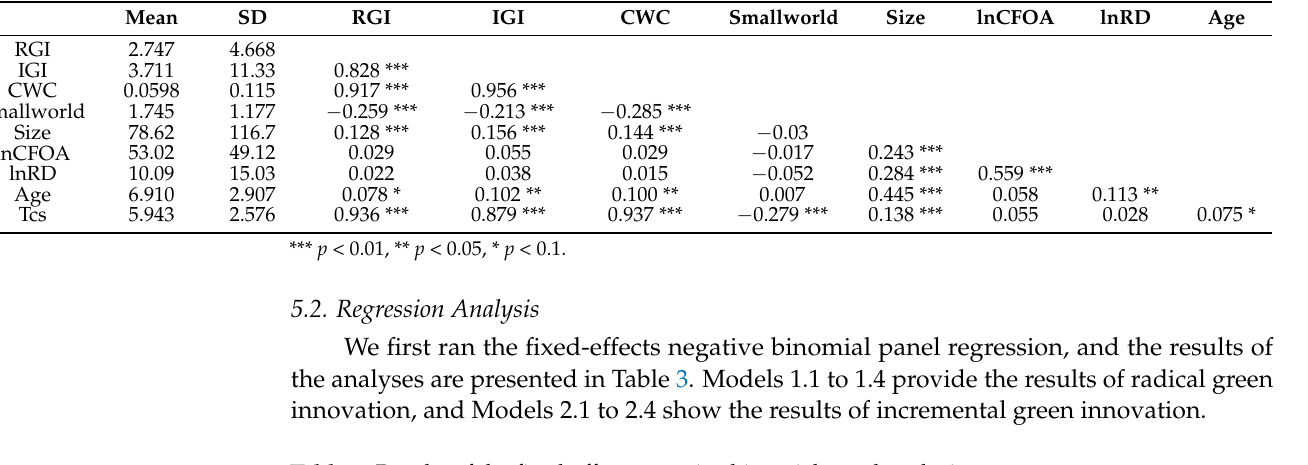
Table 3. Results of the fixed-effects negative binomial panel